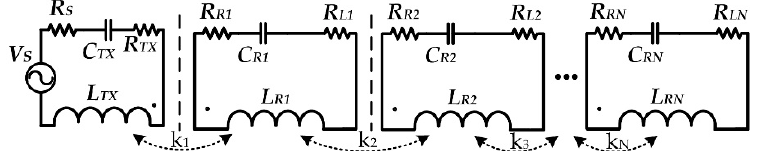
Figure 1. Circuit topology of a power relay system with a transmitter and N receivers [19].